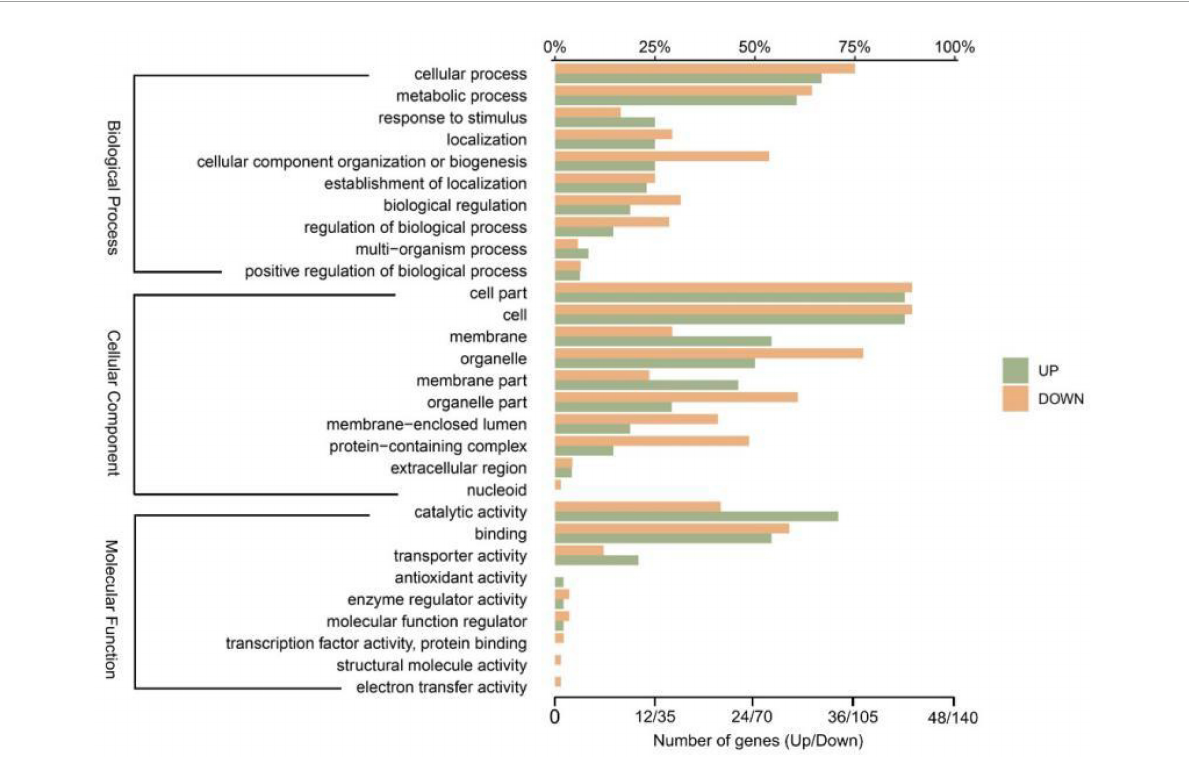
FIGURE4 GO annotation histograms for the Wyslmt strain’s DEGs. The precise classification of GO terms is represented by the vertical coordinates. The three brackets show three secondary GO database classifications (biological process, cellular component, and molecular function). The percentage of genes annotated with GO terms in relation to all genes annotated with GO terms is shown by the upper abscissa. The number of genes with GO annotations is shown in the bottom abscissa. Horizontal green and yellow bars, respectively, show the up-regulated and down-regulated